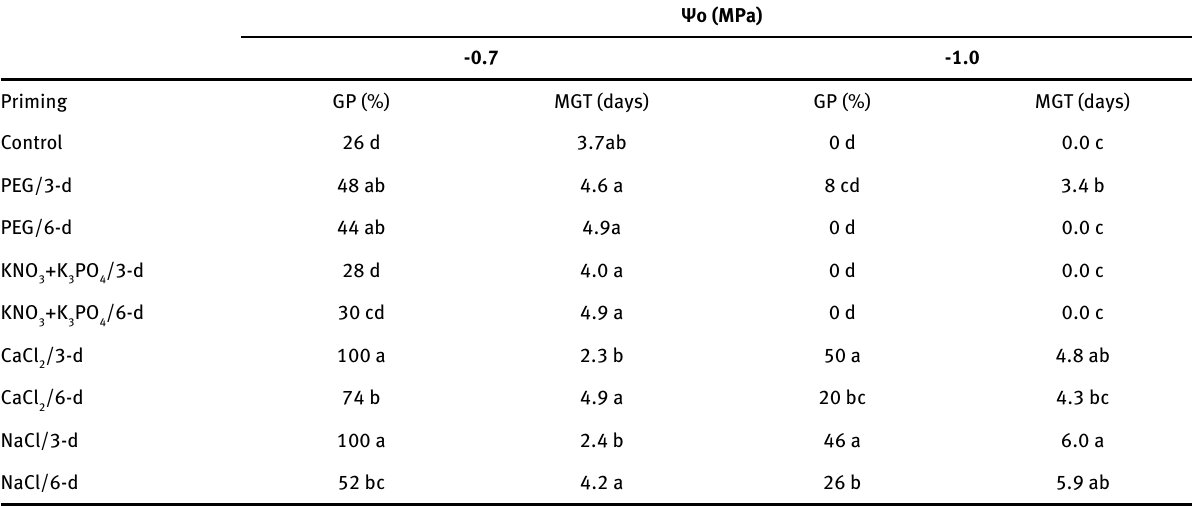
Table 2: Effect of different osmotic agents and priming durations on germination percentage (GP) and mean germination time (MGT) of melon seeds at -0.7 and -1.0 MPa